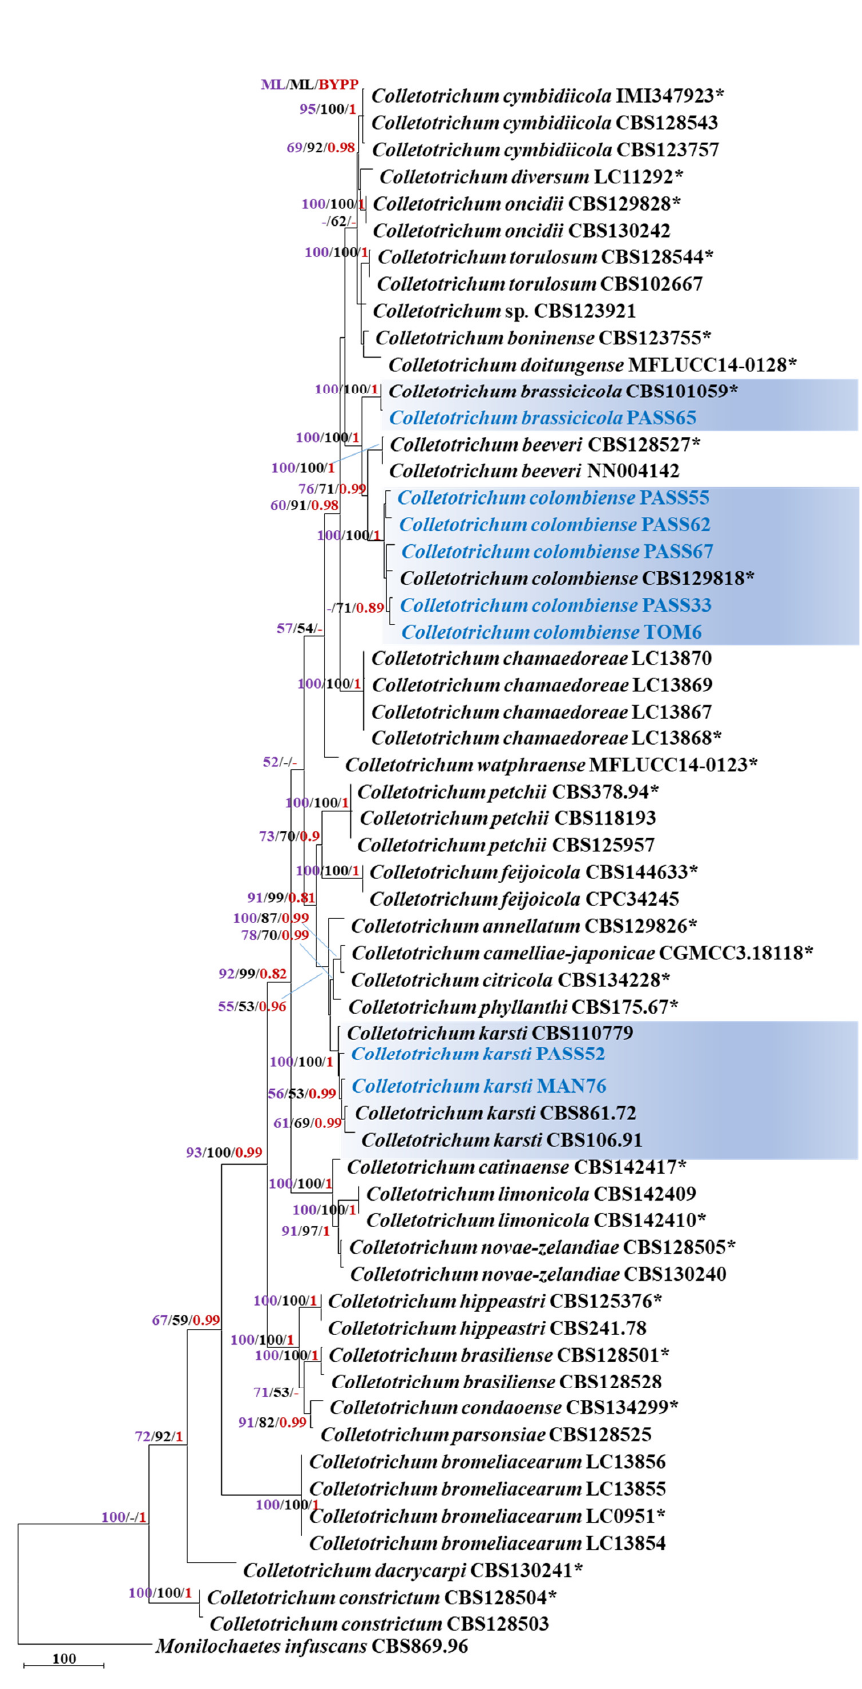
Figure 3. First of 63 equally most parsimonious trees obtained from a heuristic search of the combined ITS, act , chs1 , gapdh , his3 and tub2 sequence alignment of the Colletotrichum isolates in the